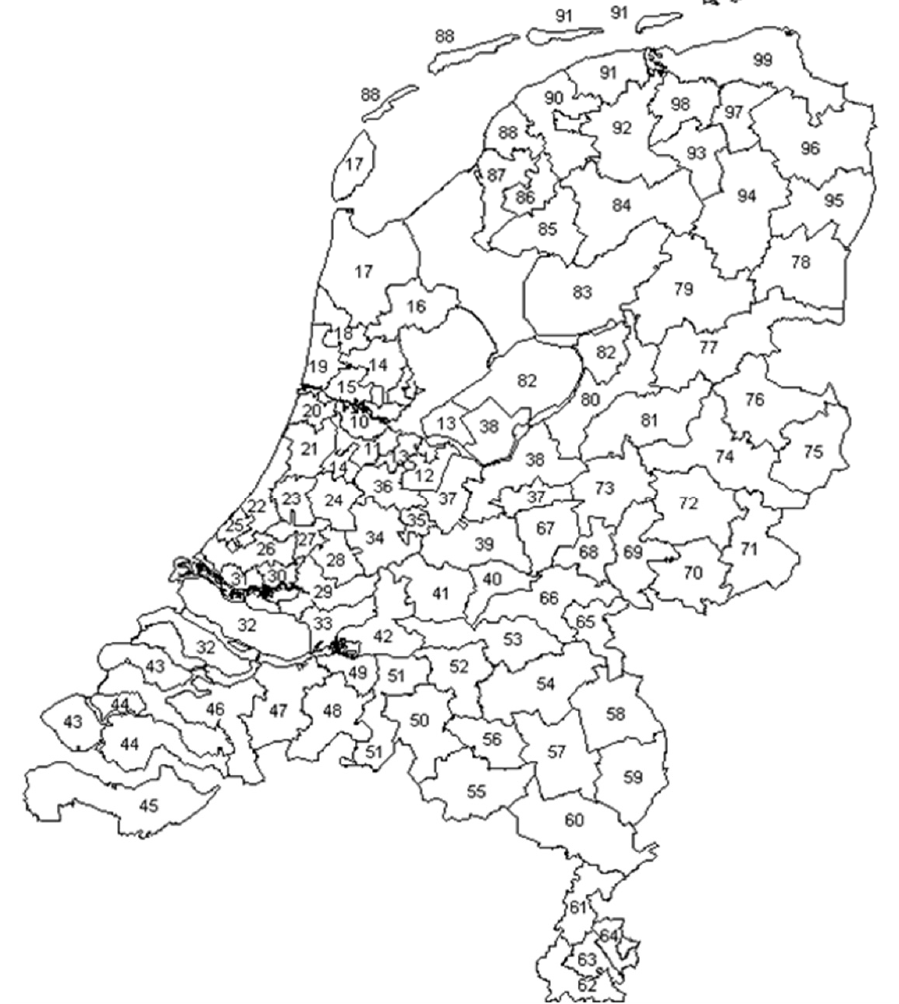
Figure 1. Distribution of the Netherlands based on the first two numbers of the postal code (PC2) [11].